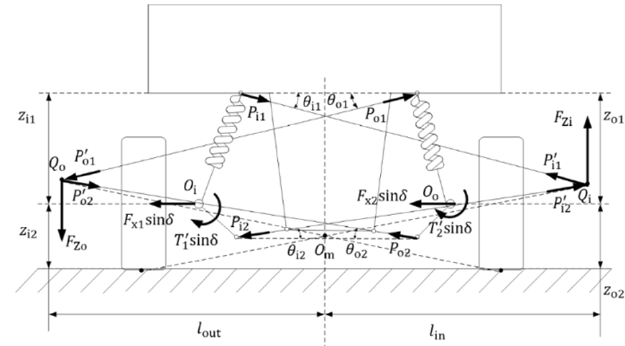
Figure 3. The force analysis of roll mechanism of lateral plane.